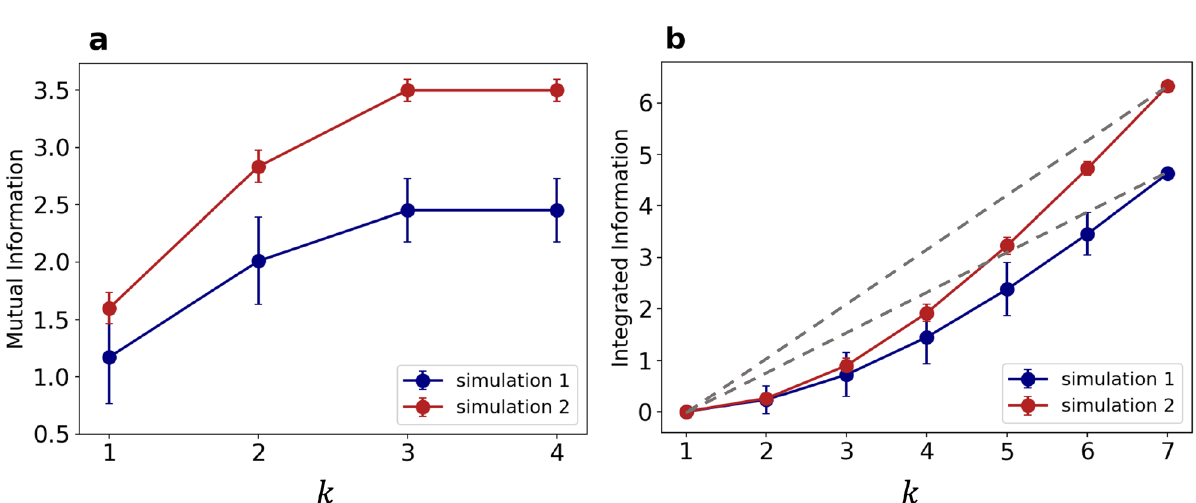
Figure 6. ( a ) MI ( k ) computed from two statistically independent simulations at (cid:31) V = 1 V (blue and red), as a function of the number of subregions, k , considered. ( b ) IN ( k ) computed for the same simulations. In both cases, data are collected over 200 distinct MC configurations and errorbars are given by the evaluation of these observables over all the different ways of choosing a given k . Grey dashed lines represent the IN growth in a fully correlated